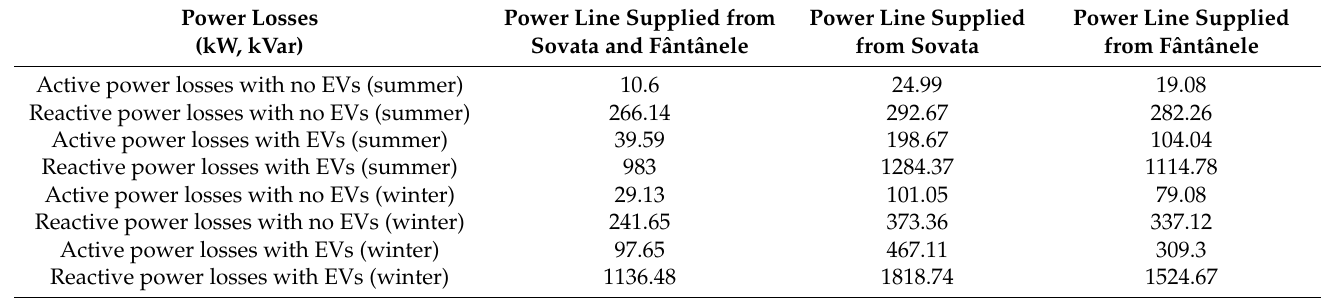
Table 24. Power losses at 15:00 (scenario 5).